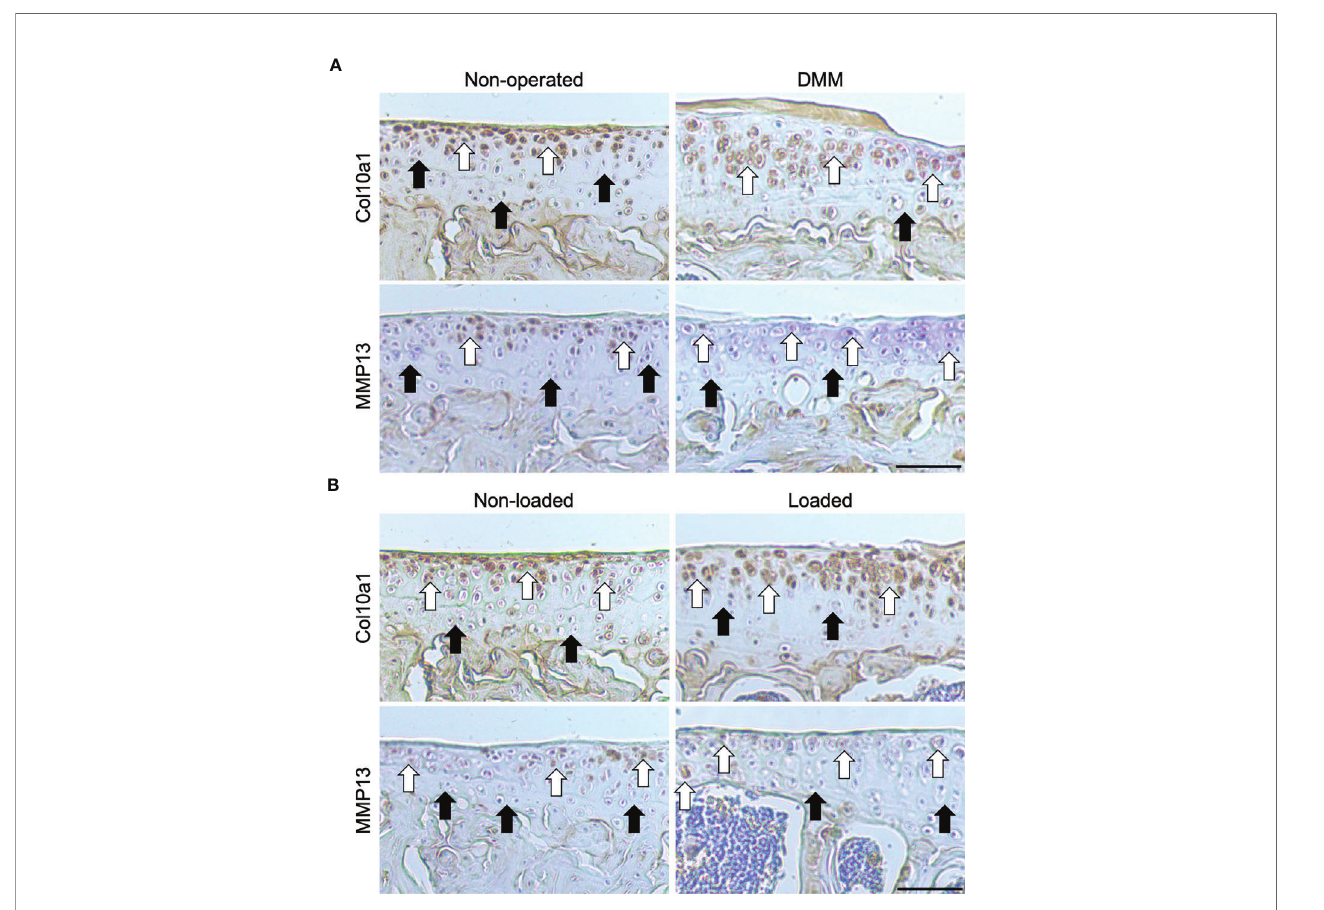
FIGURE 1 | Immunohistochemical labelling in the tibial articular cartilage of mouse knee joints. Immunohistochemical labelling for type X collagen (Col10a1) and matrix metalloproteinase (MMP13) in the 6 m m coronal sections of articular cartilage of non-operated and DMM (A) , or non-loaded and mechanically loaded (B) middle regions of knee joints of C57BL/6 male mice. White arrows indicate examples of positive labelling, and black arrows indicate a lack of labelling, in the tibiae. Images are representative of results in 4 individual mice. Scale bar = 50 m